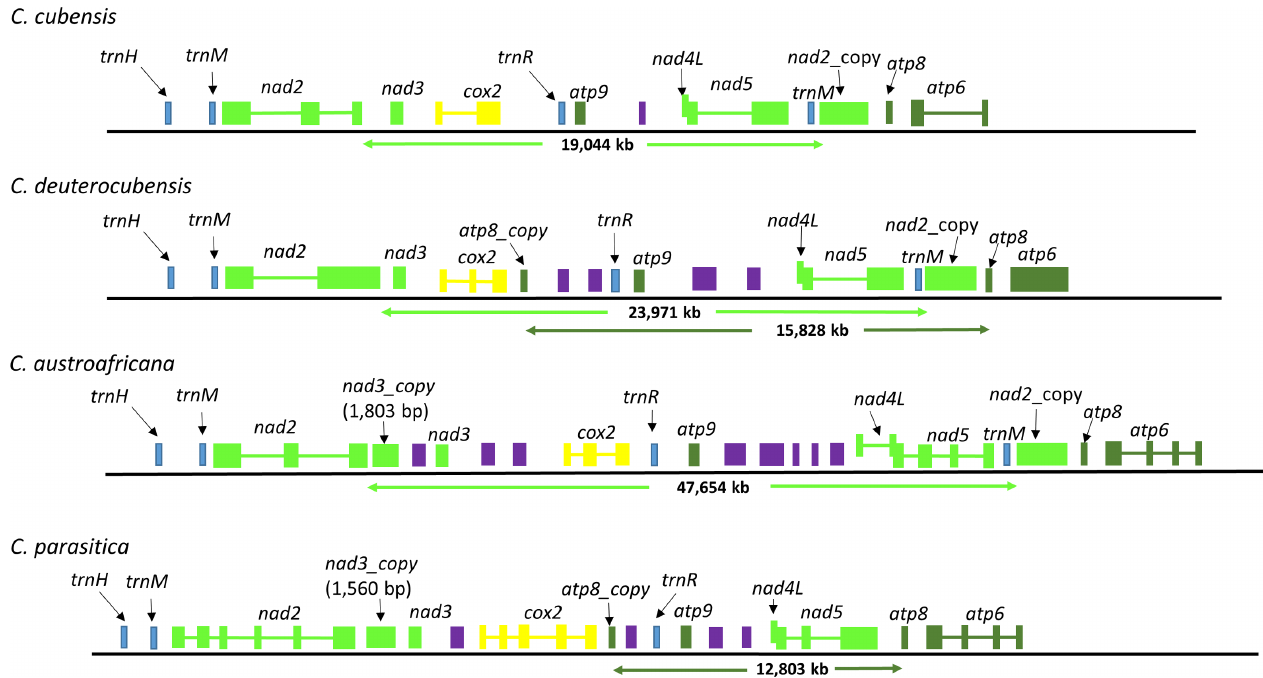
Fig 3. Organization of genes around the nad2 , nad3 and atp8 genes showing partially duplicated sequences. Dark green, light green, olive green, red, yellow, light blue and purple boxes represent the nad2 , nad3 and nad5 , cox2 , atp9 , tRNAs genes and various open reading frames (ORFs), respectively. The duplicate genes are denoted as nad2_copy , atp8_copy and nad3_